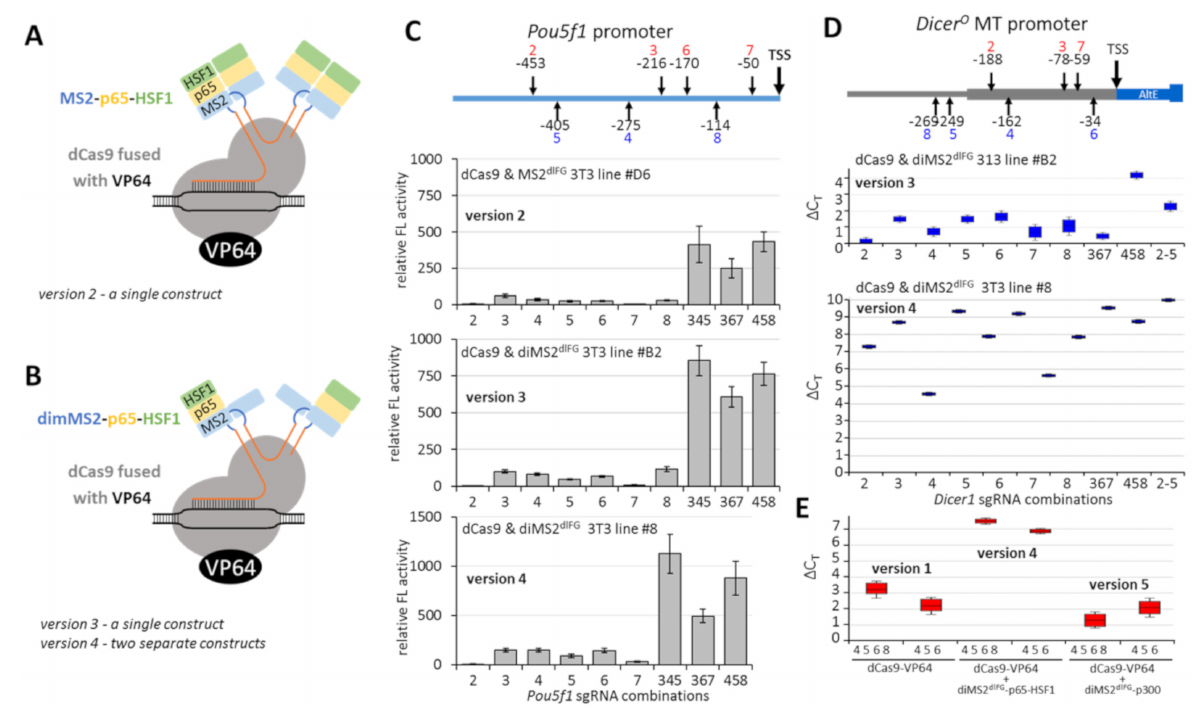
Figure 3. Transcriptional activation using dCas9-VP64 enhanced with MS2 systems. ( A ) Schematic depiction of version 2 based on dCas9-VP64, modified sgRNA with MS2-binding sequence (blue) and MS2 domain fused with p65 and HSF1. The scheme indicates that the MS2 fusion construct is dimerizing on the RNA sequence. ( B ) Schematic depiction of versions 3 and 4. The difference from (A) lies in MS2 being encoded as a covalently linked duplex where one MS2 is fused with p65 and HSF1 (dimMS2-p65-HSF1). Versions 3 and 4 differ in the organization of expression. Version 3 expresses dCas9-VP64 and dimMS2-p65-HSF1 from a single construct, version 4 from separate constructs. ( C ) Transcriptional activation of Pou5f1 promoter-reporter with versions 2, 3, 4. As in Figure 1C, shown are relative firefly luciferase activities normalized to the Renilla control reporter; firefly reporter activity in the absence of sgRNA was set to 1. ( D ) Transcriptional activation of the endogenous MTC promoter in NIH 3T3 cells. The graph depicts relative expression calculated by the ∆∆ C T method. ( E ) Comparison of transcriptional activation of the endogenous MTC promoter in NIH 3T3 cells of version 4 with version 1 (Figure 2) and version 5, which uses dimMS2-p300 instead of dimMS2-p65-HSF1. The graph depicts relative expression calculated by the ∆∆ C T method. All error bars = standard